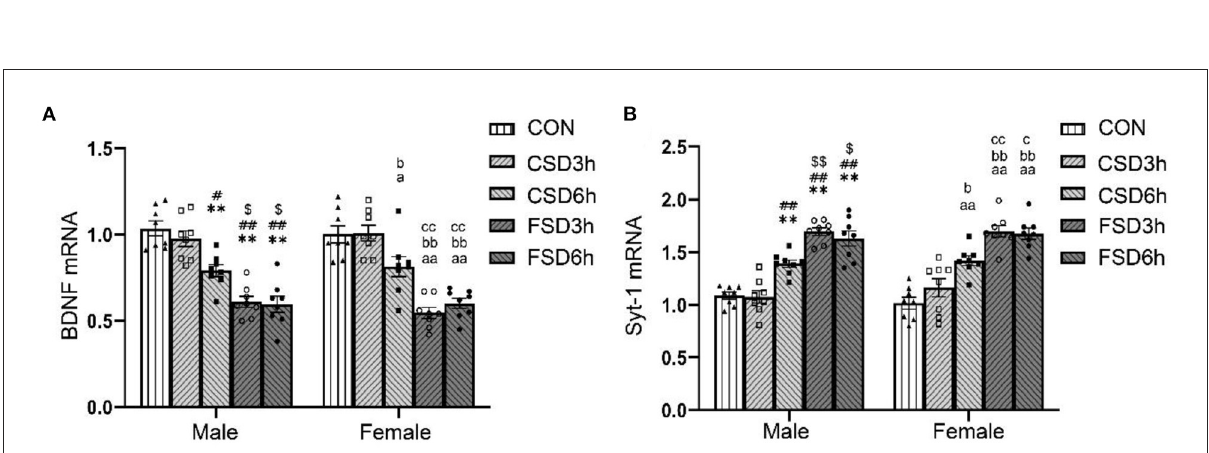
FIGURE6 The effects of MSD on the expression of hippocampal of BDNF and Syt-1 mRNA in the offspring. The mRNA expression levels of BDNF ( n = 16, 8 females and 8 males in each treatment group) and Syt1 ( n = 16, 8 females and 8 males in each treatment group) in the hippocampus at 2 months. The results of mRNA quantification are depicted in (A,B) . ** P < 0.01 vs. Male CON group; # P < 0.05 and ## P < 0.01 vs. Male CSD3h group; $ P < 0.05 and $$ P < 0.01 vs. Male CSD6h group; a P < 0.05 and aa P < 0.01 vs. Female CON group; b P < 0.05 and bb P < 0.01 vs. Female CSD3h group; c P < 0.05 and cc P < 0.01 vs. Female CSD6h